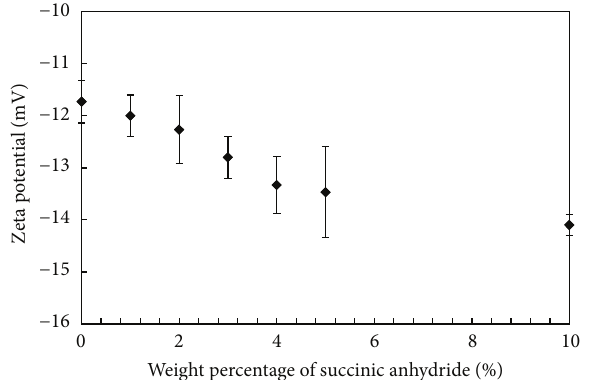
Figure 2: The influence of succinic anhydride weight percentage against Ap -SF on zeta potential.